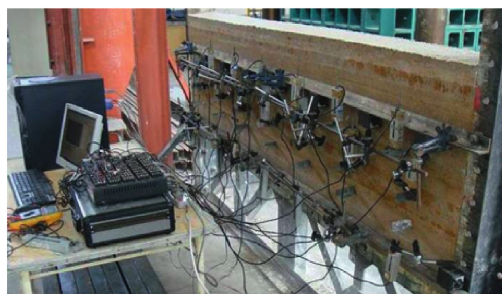
Figure 1: Two-dimensional plane stress test bench.